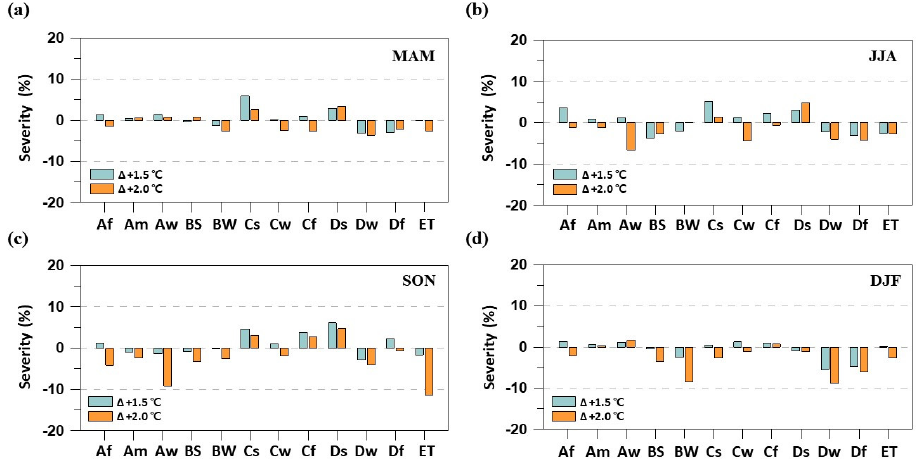
Figure 10. Relative changes in the ( a – d ) seasonal mean severity of severe drought (unit: %) based on SPI3 under 1.5 and 2.0 ◦ C global warming compared to the reference period in the Asian monsoon region.